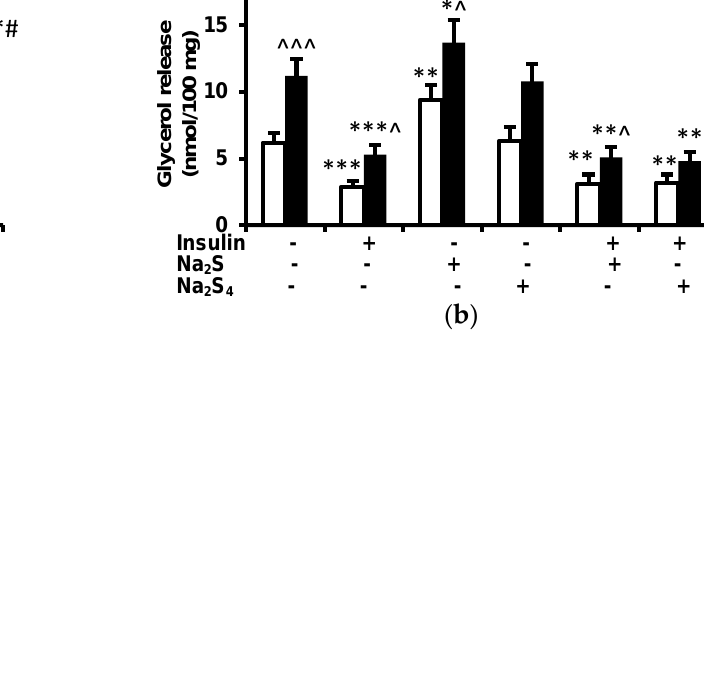
( f ) Figure 5. E ffect of insulin, Na 2 S, and Na 2 S 4 on glucose uptake ( a ), glycerol release ( b ), tyrosine phos- phorylation of IRβ ( c ), tyrosine phosphorylation of IRS-1 ( d ), Akt1 phosphorylation ( e ), and cAMP concentration ( f ) in mesenteric adipose tissue isolated from lean (white) and obese (black) rats. * p < 0.05, ** p < 0.0, *** p < 0.001 vs. samples not treated with insulin, Na 2 S, and Na 2 S 4 collected from the respective group of rats (lean or obese), ^ p < 0.05, ^^ p < 0.01, ^^^ p < 0.001 vs. adipose tissue samples treated in the same manner collected from lean rats, # p < 0.05 vs. samples from the respective group (lean or obese) treated with insulin alone. 3.5. Effect of Insulin, Na 2 S, and Na 2 S 4 on Glycerol Release by Adipose Tissue Ex Vivo Glycerol release in the absence of insulin was higher in obese than in lean rats. Insulin reduced glycerol release in lean and obese rats by 53.2% and 52.7%, respectively. These results suggest that the antilipolytic effect of insulin is preserved in obese rats, although glycerol release in the presence of insulin remained higher in obese rats. Na 2 S stimulated lipolysis in both lean and obese groups whereas Na 2 S 4 had no effect. Glycerol release in the presence of insulin and Na 2 S or insulin and Na 2 S 4 was similar to that in the presence of insulin alone in both lean and obese groups (Figure 5b).